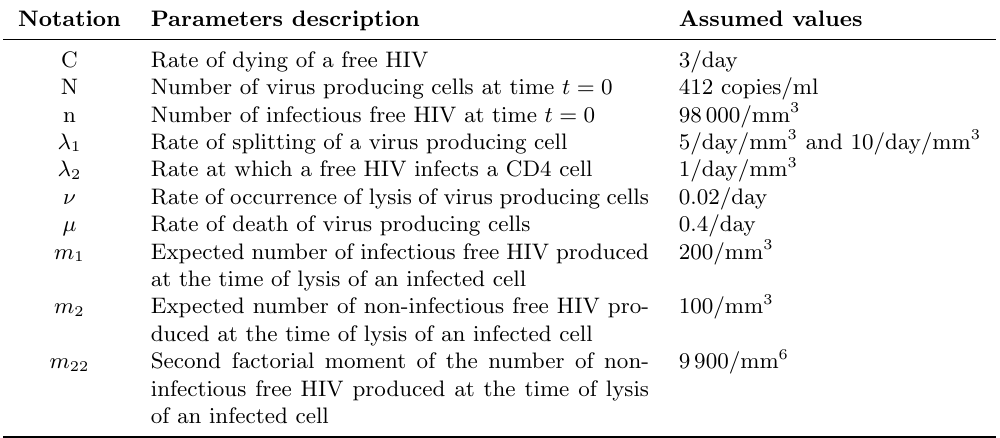
Table 1: Assumed values of parameters used to obtain numerical